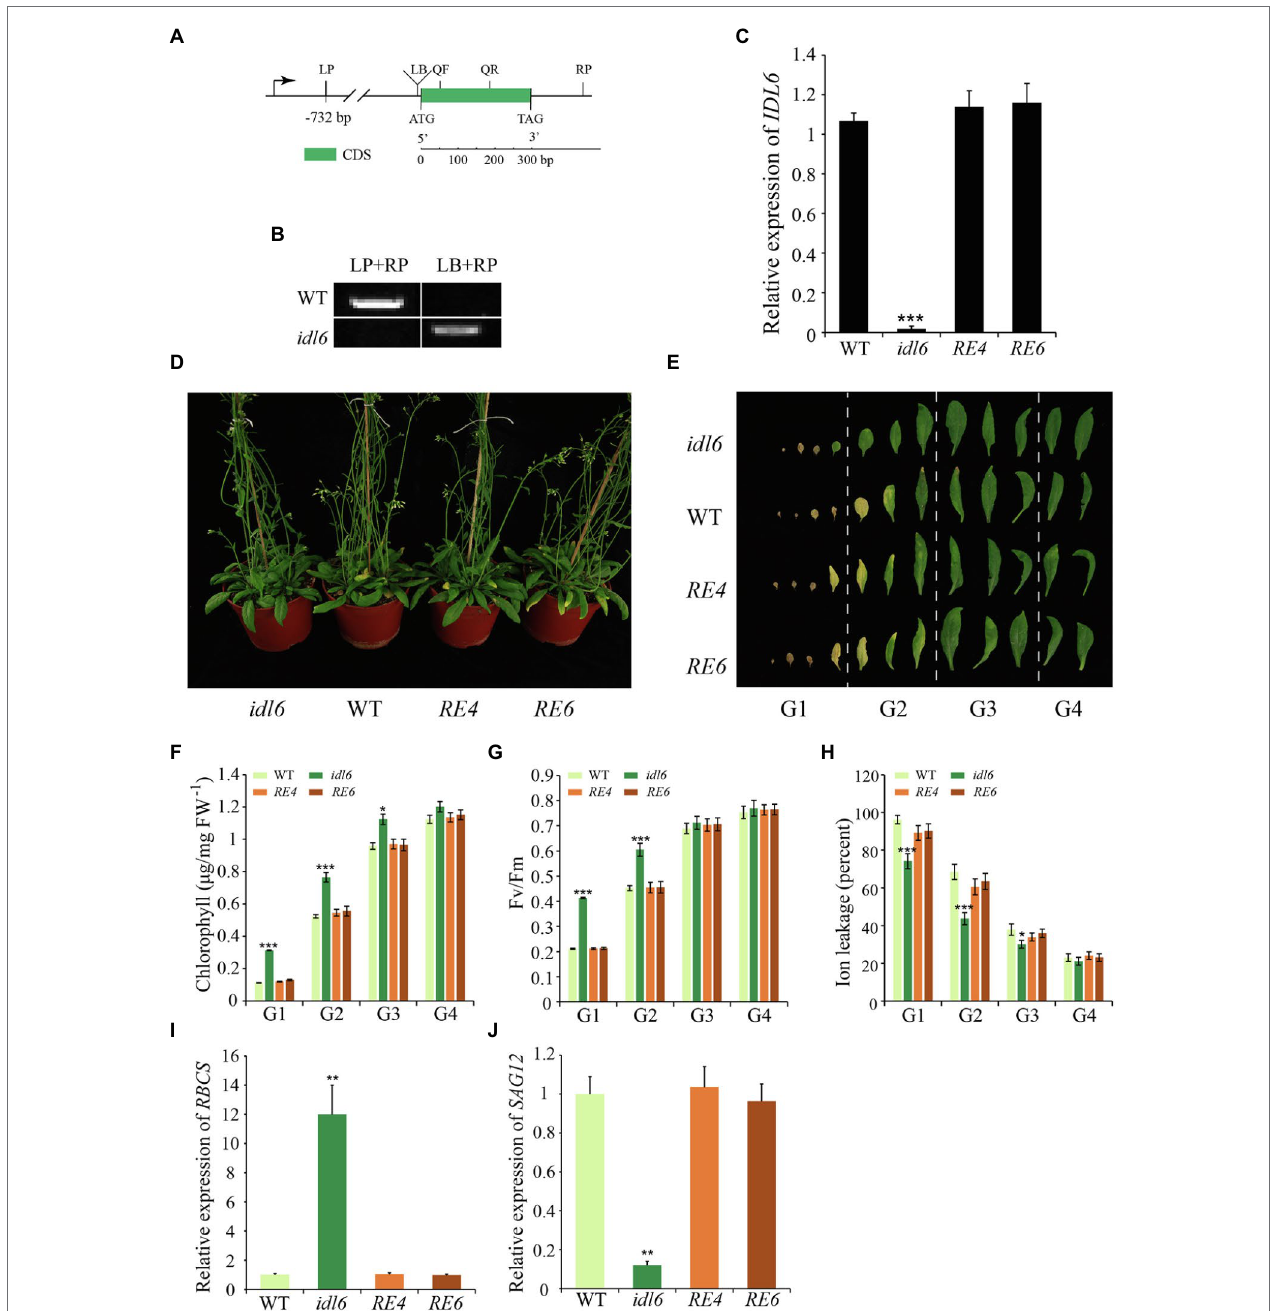
FIGURE 4 | Leaf senescence phenotypes of IDL6 loss-of-function plants. (A) The gene structure of the IDL6 gene and location of the T-DNA insertion. (B) Homozygous mutant plants were identified by PCR. LP: left primer, RP: right primer, LB: T-DNA left border primer. (C) Quantification of IDL6 transcripts in